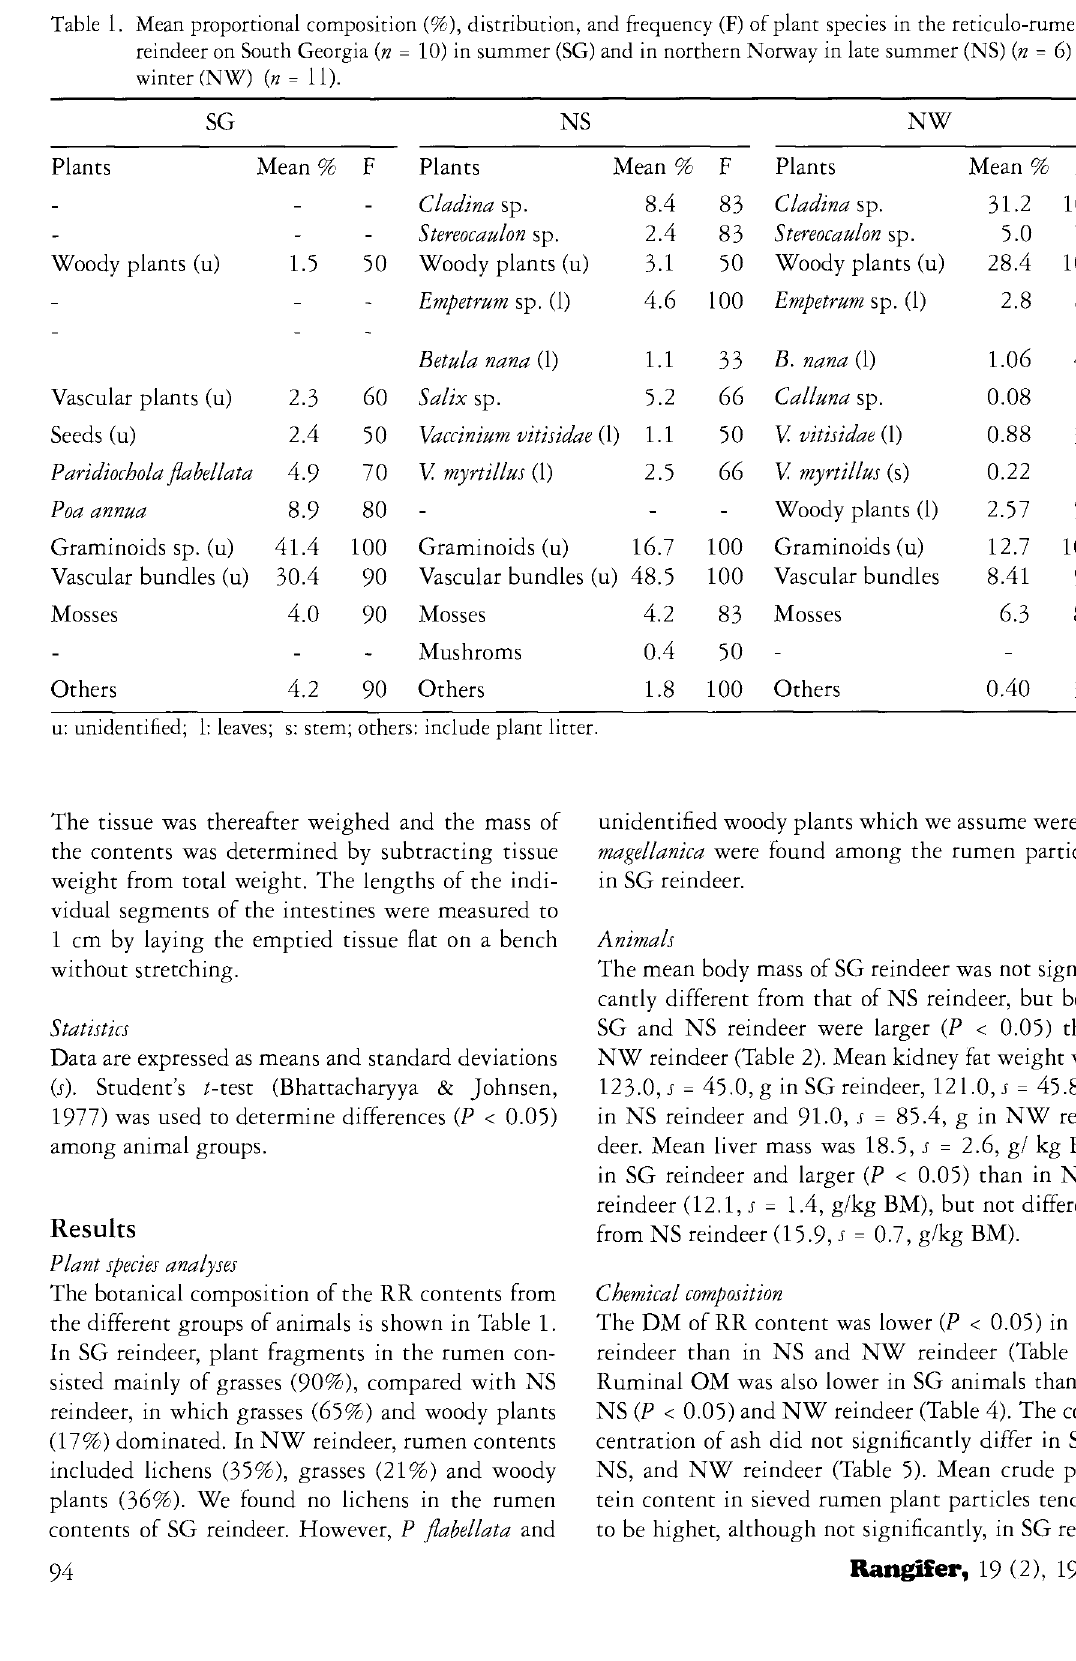
Table 1. Mean proportional composition (%), distribution, and frequency (F) of plant species in the reticulo-rumen of reindeer on South Georgia (n = 10) in summer (SG) and in northern Norway in late summer (NS) (n = 6) and winter (NW) (n =